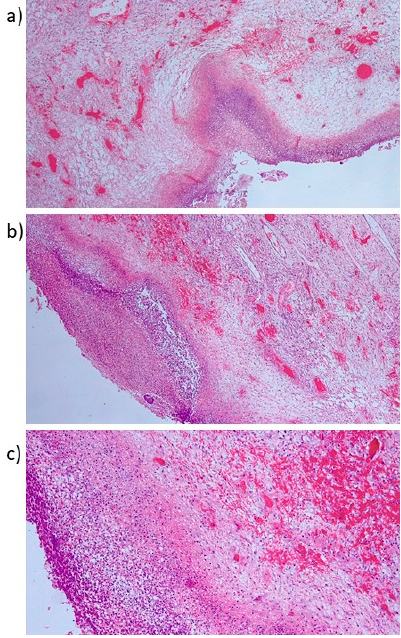
Figure 2. Definitive histopathological examination: ( a , b ) actinic necrosis in pelvic abscess (Hema- toxylin-Eosin, HE, 100×); ( c ) magnified vision (200×) of necrotic debris and suppurated acute in- flammation